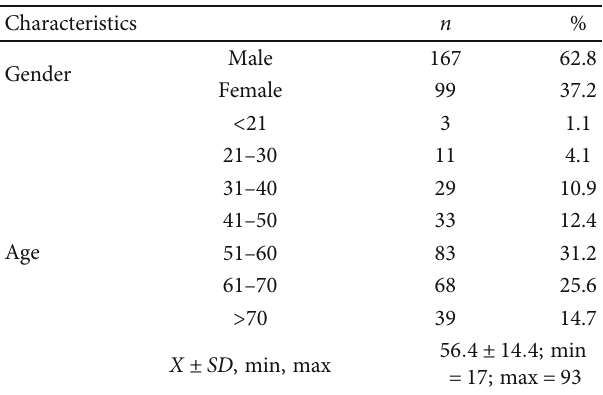
Table 1: General characteristic of